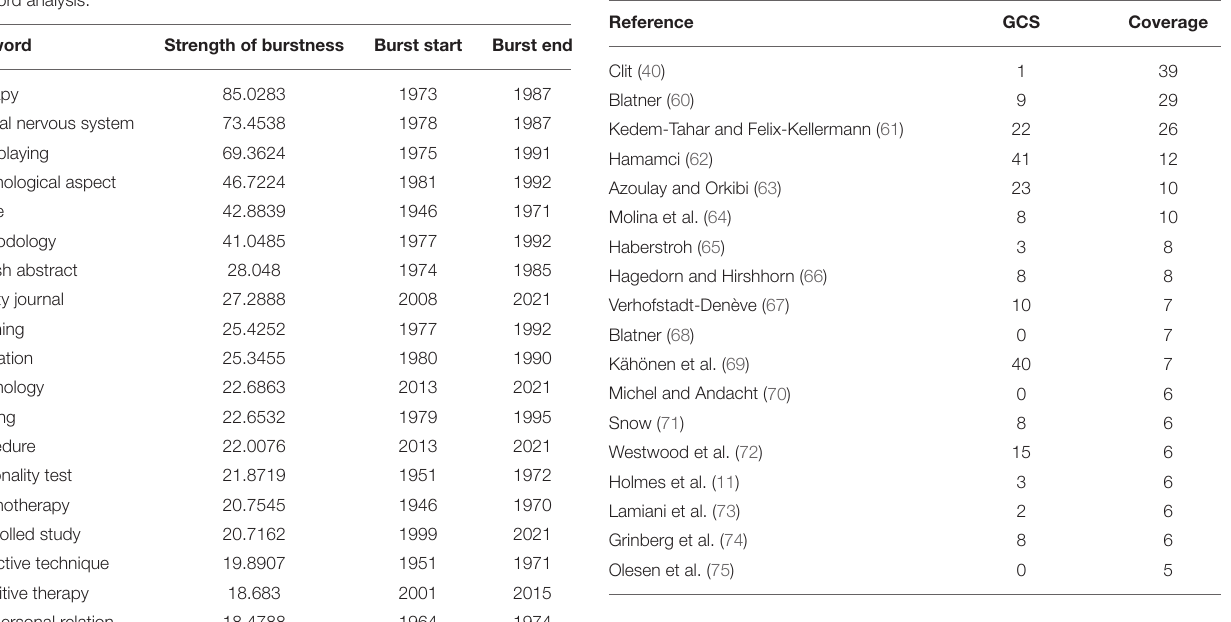
TABLE 4 | Citing papers belonging to cluster